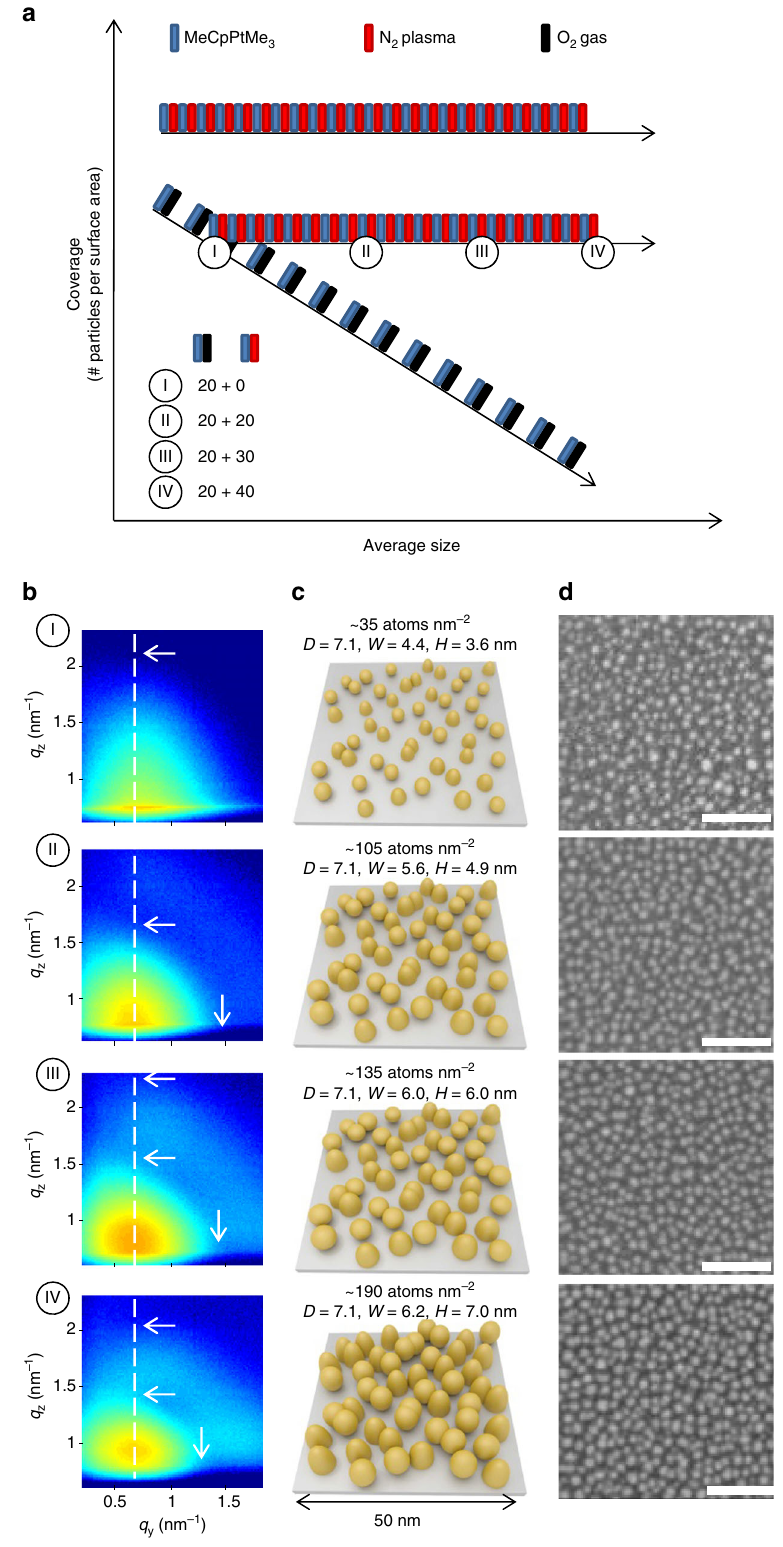
Fig. 7 Precise control of size of Pt nanoparticles using ALD. Tuning the particle size at a fi xed particle coverage by combining 20 O 2 -based Pt ALD cycles with 0 (sample I), 20 (sample II), 30 (sample III), and 40 (sample IV) N 2 * -based Pt ALD cycles. a ALD recipe scheme. For clarity, fewer than the real number of ALD cycles are schematically represented. b Experimental 2D GISAXS images. The dashed vertical lines indicate the q y -position of the main scattering lobe. The horizontal/vertical arrows indicate the minima along the q z / q y -direction. c Schematic representations of the GISAXS results. The Pt loading, mean center-to-center particle distance 〈 D 〉 , average particle width 〈 W 〉 , and average particle height 〈 H 〉 are indicated. d SEM images with 50 nm scale